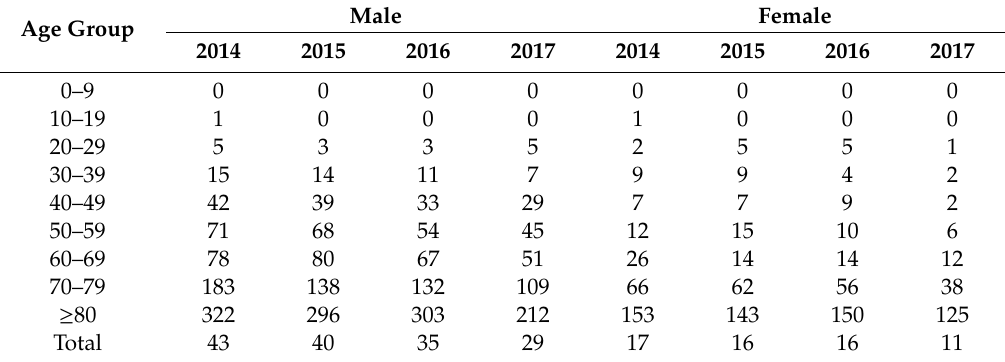
Table 1. Years of life lost due to tuberculosis per 100,000 population in Korea by sex and age, 2014–2017. Male Female Age Group